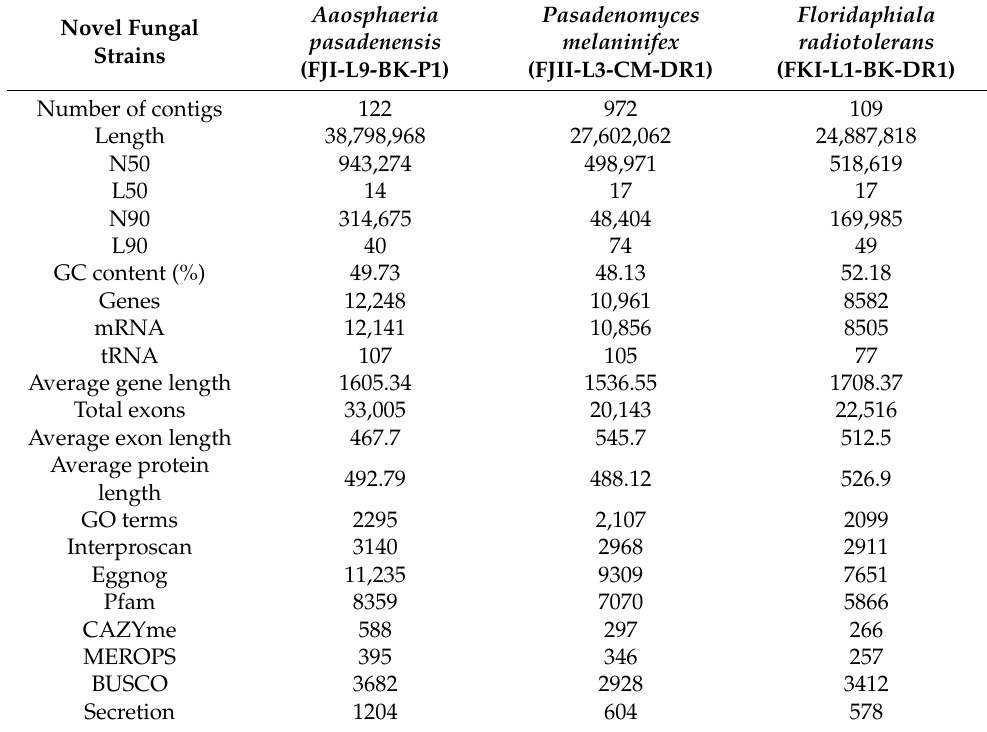
Table 1. Genome features and other genomic annotations of three novel